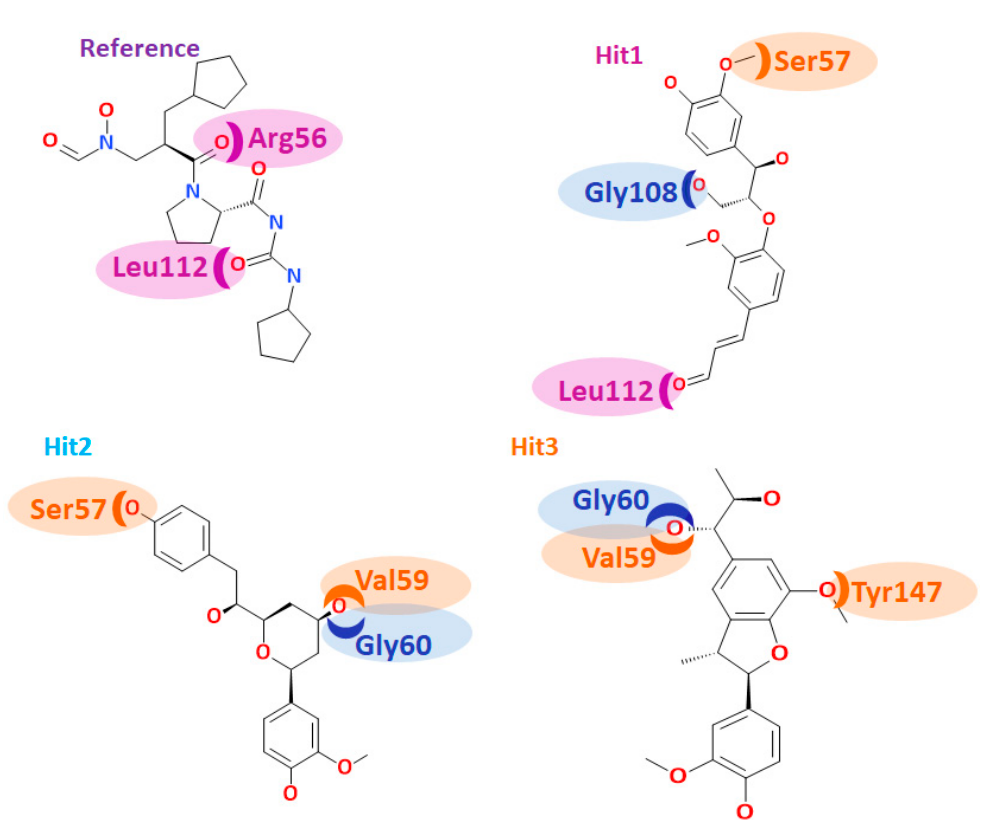
Figure 8. Subsite occupation of the compounds. The residues from S1’ region are represented in blue, the residues from S2’ region are indicated in purple and the residues from S3’ region are represented in orange colour, respectively.